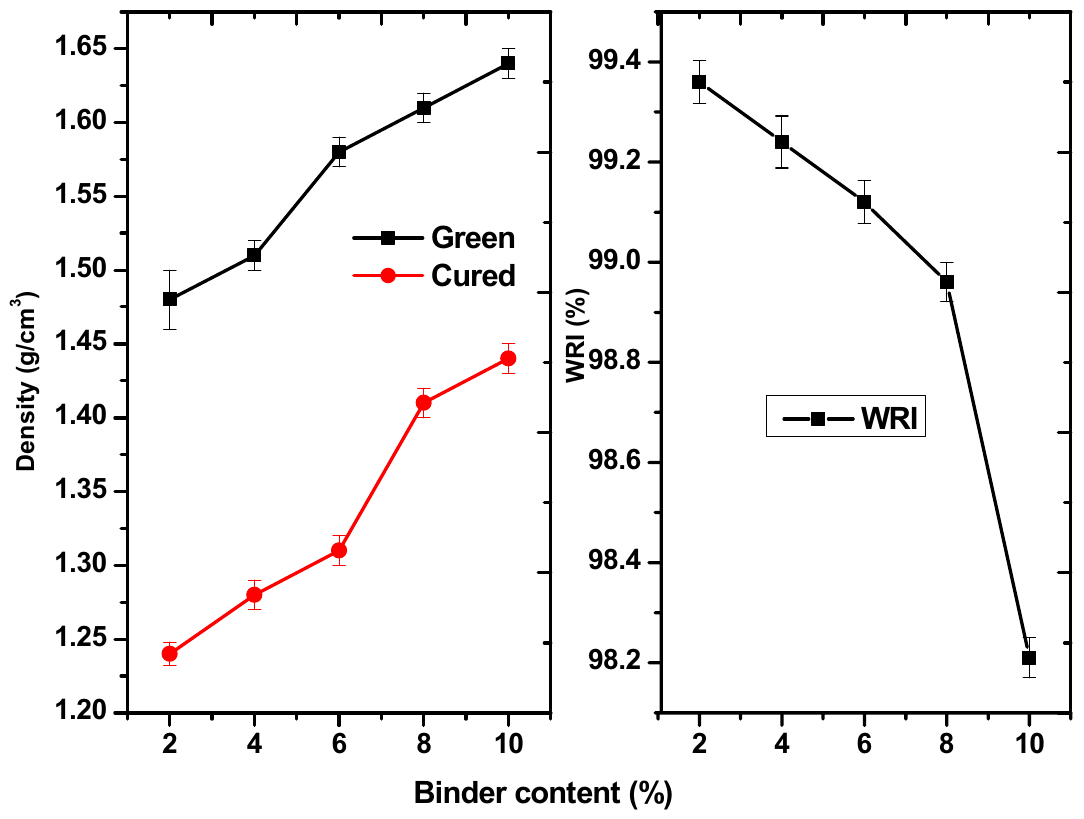
Figure 2. Physical properties of the fuel briquettes ( a ) density, ( b )